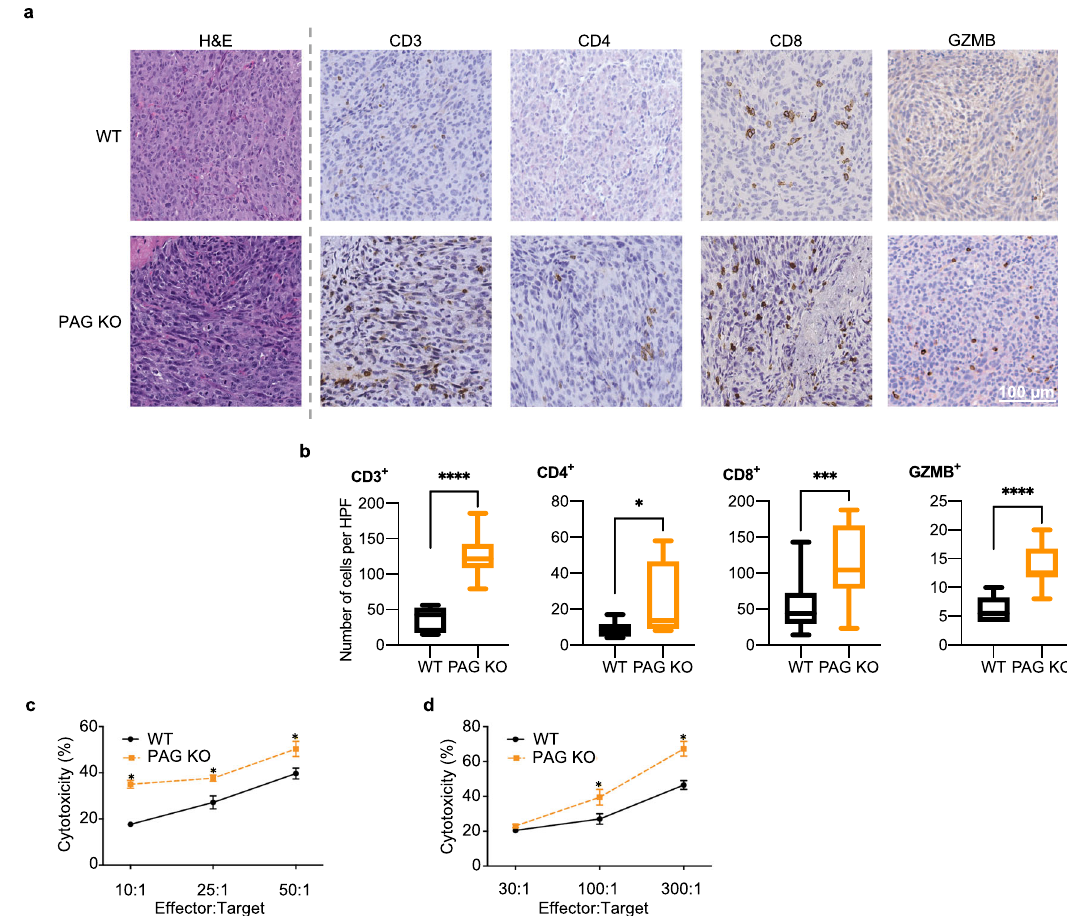
Fig. 6 In the absence of PAG, T cells are more active. a Immunohistochemical staining for CD3 + , CD4 + , CD8 + , and granzyme B + (GZMB) in fi ltrating cells in MC38 tumors from WT and PAG KO mice at day 19 after tumor implantation. b Quanti fi cation of CD3 + , CD4 + , CD8 + , and GZMB + cells per high powered fi eld (HPF) of the staining represented in a . Ten to fi fteen HPFs were analyzed from each group. c IL-2 primed splenocytes (effector cells) from WT and PAG KO mice were co-cultured overnight with L929 cells (target cells). The release of LDH from the lysed target cells was measured and cytotoxicity was calculated relative to target cells cultured in the absence of primed T cells. d Puri fi ed CD8 + T cells (effector cells) were isolated from WT and PAG KO mice and co-cultured with Raji cells (target cells) pre-loaded with SEE. The release of LDH from the lysed target cells was measured and % cytotoxicity was calculated relative to target cells cultured in the absence of primed T cells. * p < 0.05; *** p < 0.001; **** p < coated wells, incubated for 15 min, and nonadherent cells removed by serial washes. The number of adherent cells remaining, expressed as a percentage of the total number of labeled cells, was determined with a fl uorescent plate reader (Synergy HT, BioTek Instruments). Each experiment was performed three times. Immunoprecipitation and western blot . Cell lysates were mixed with anti-GFP monoclonal antibody coupled to agarose beads to enrich GFP-tagged proteins according to the manufacturer ’ s protocols (MBL). Pull-down lysates were separated by Tris-glycine PAGE, transferred to nitrocellulose membranes, and visualized as described 20 . The following antibodies were used for biochemical assays: anti- phosphotyrosine (4G10; Millipore), anti-GFP-agarose (D153; MBL), anti-GFP (118144600; Roche), anti-pERK (9106; Cell Signaling), anti ERK (4695; Cell Sig- naling), anti-pSRC (2105; Cell Signaling), anti-SRC (2108; Cell Signaling), anti- pZap70 (2701; Cell Signaling), anti-actin (1616; Santa Cruz), anti-PAG (MEM-255, Origene). Prior to pERK and pSRC analysis, primary human and Jurkat T cells were stimulated for 5min, lysed in modi fi ed 1× RIPA buffer containing protease and phosphatase inhibitors. Lysates were separated by Tris-glycine PAGE, trans- ferred to nitrocellulose membranes, and visualized as described 20 . Flow cytometry . Non-permeabilized T cells were stained with the fl uorescently conjugated antibody speci fi c for CD69 (H1.2F3; BioLegend) in FACS Buffer [HBSS without Ca 2 + / Mg 2 + , FBS (3%), NaN 3 (0.02%), and CaCl 2 (2.5 mM)], then washed and fi xed in 1% paraformaldehyde. PAG-GFP expressing cells were fi xed in 1%